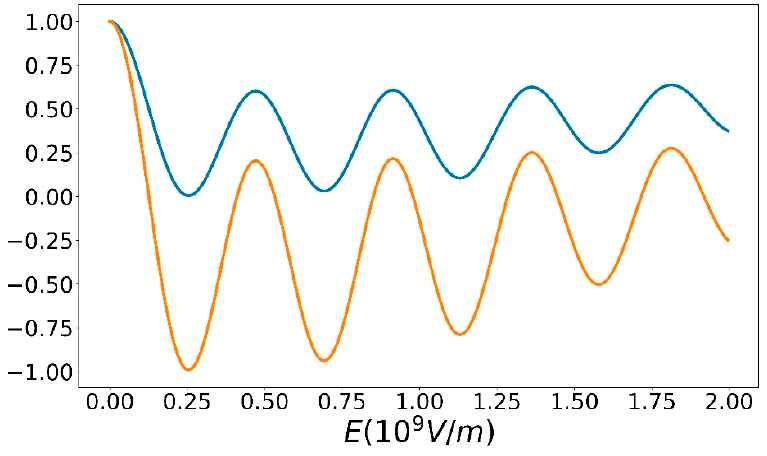
Figure 4. The probability that electrons stay at 0 S and the final state of spins at 1 ps after the laser incidence are presented in blue and orange lines, respectively.